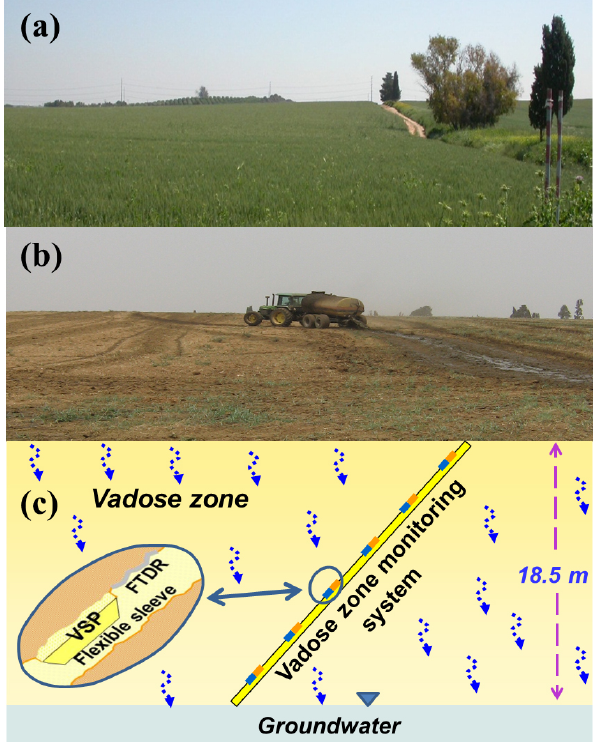
Figure 1. Crop field site with monitoring location during two pe- riods: crop growth during the wet season (a) , and after harvesting and during slurry application (b) . (c) Schematic illustration of the vadose-zone monitoring system installed under the crop field. VSP, vadose-zone sampling port; FTDR, flexible time-domain reflectom- etry